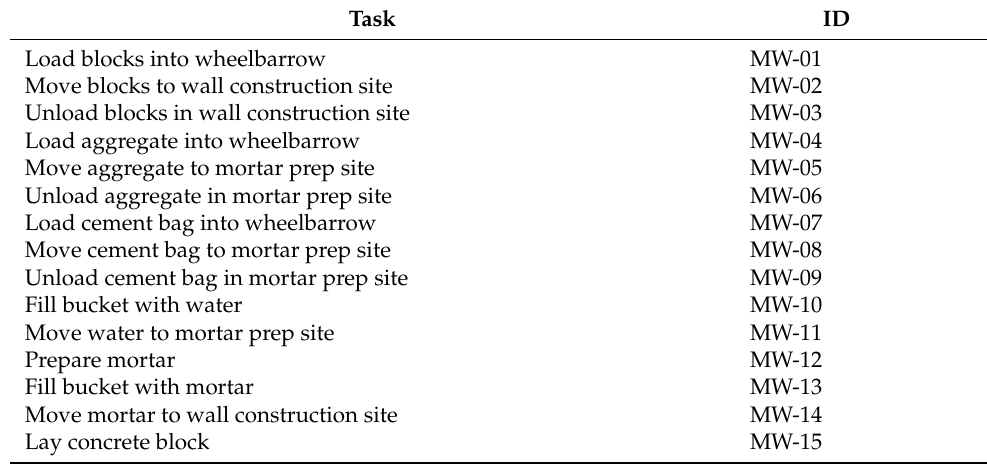
Table 1. Work breakdown structure of the modelled